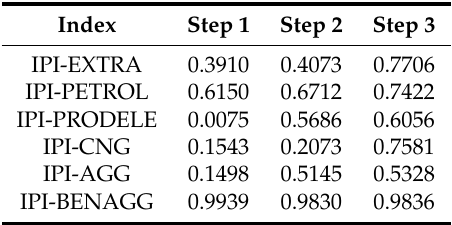
Table 26. Comparison of ratios between mean absolute errors with an expanding window for electricity from 2008:01 to